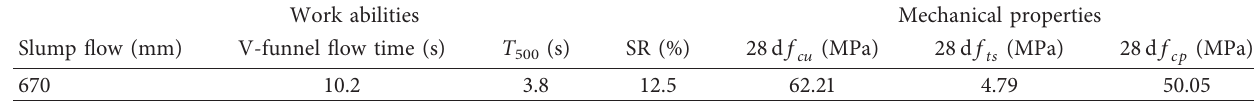
Table 13: Results of the optimal mix